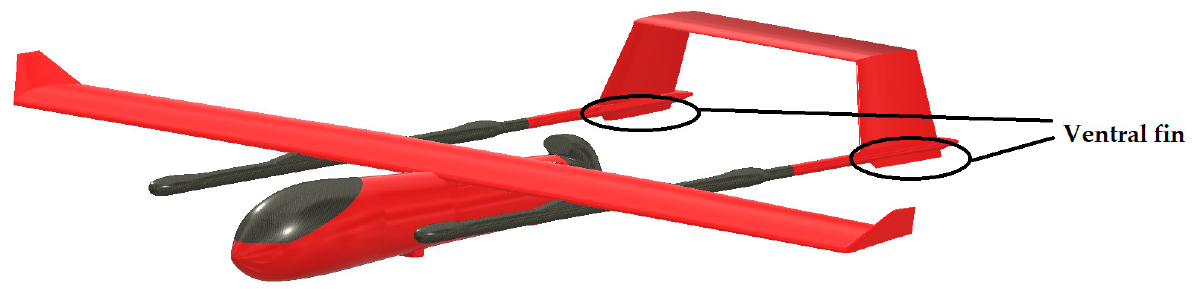
Figure 21. Ventral fin added to improve aerodynamics performance.